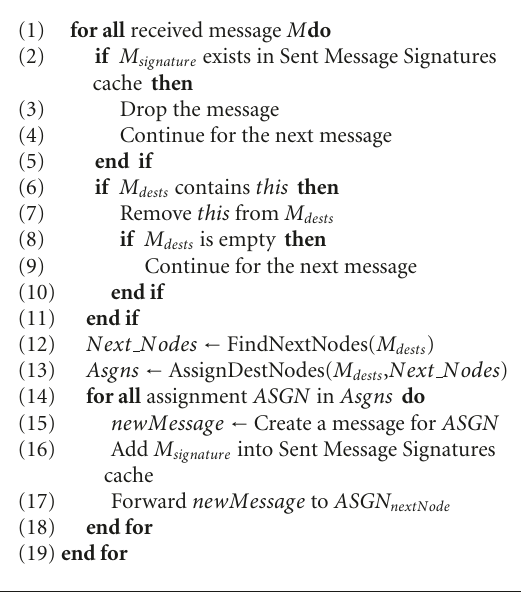
Algorithm 1: Greedy Multicast Forwarding in PBM.